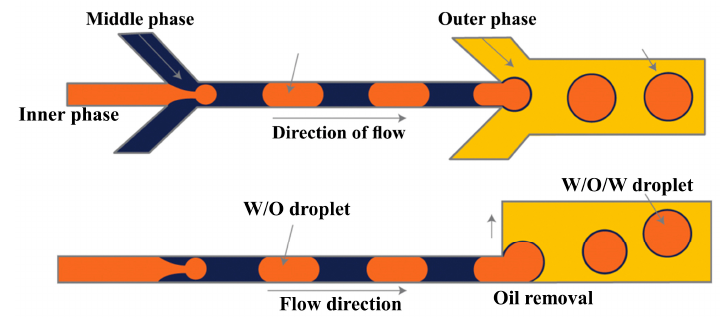
Figure 15. PDMS device for the formation of core/shell drops with ultra-thin shells (top and side views). The oil phase was drained from the shell by flowing away along the hydrophobic surface of the W/O/W channel [144].